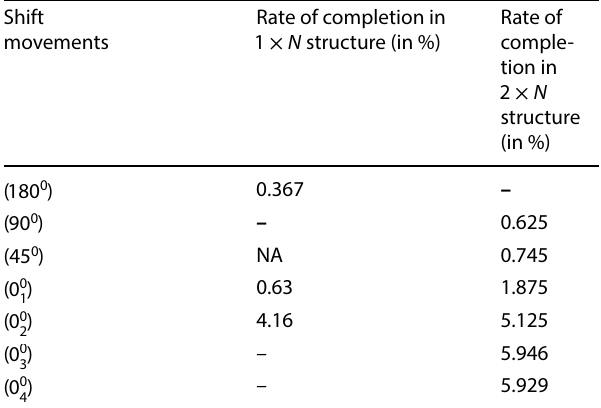
Rate of completion in 1 × N structure (in %)